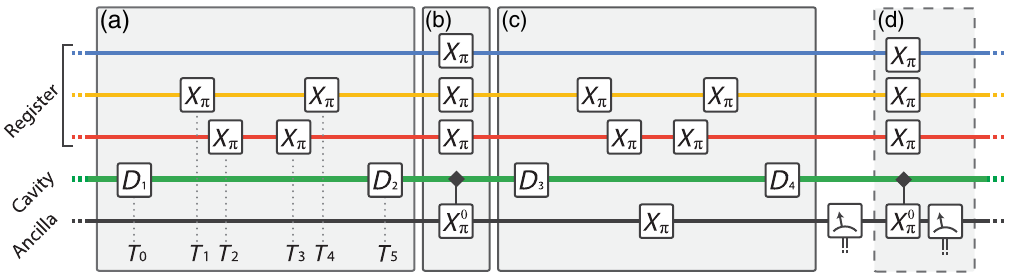
FIG. 2. Circuit diagram for ZIZ measurement. Steps X π refer to one-qubit rotations around the X axis by π radians. Steps X 0 π indicate that the pulses are spectrally narrow and are roughly selective on having zero photons in the cavity. Steps D represent unconditional i displacements of the cavity. The meters are measurements of the ancilla via the readout resonator, which is not itself depicted. The ancilla has the largest dispersive shift and the register qubits are then numerically ordered (from top to bottom) such that χ 1 < χ 2 < χ 3 . Prior to this procedure a series of measurements is applied to postselectively prepare the ground state; see the Supplemental Material for details [32]. (a) The algorithm begins with a displacement D 1 to create a coherent state of ¯ n ¼ 5 photons into the cavity, which acquires a phase shift θ in a time T ¼ T 5 − T 0 ≈ θ = ð 2 πχ 1 Þ conditionally on the state of qubit 1 (blue line). For measurements of one- and two-qubit properties, θ ¼ 2 π = 5 . In this example, we perform a full echo on the second qubit (yellow line) by performing two unconditional X gates separated in time by T 4 − T 1 ≈ T= 2 . The third qubit (red line) would contribute a conditional phase shift of 2 πχ 3 T > θ . We reduce this to θ by performing two X π gates separated by T 3 − T 2 ≈ θ ð χ − 1 1 − χ − 1 3 Þ = 2 . At T 5 , we perform D 2 to shift the odd two-parity coherent-state pointer to the zero-photon state. Note that the overlaps between the even two-parity pointer states and the zero-photon state are exponentially suppressed. (b) We map this photon number information onto the ancilla qubit with a X 0 π gate, taking advantage of the well-known number-splitting phenomenon [35]. As the cavity states are separated by ≈ 6 . 5 photons, we employ a faster, approximately selective gate, 300 ns in duration. X π gates on the register are centered on this pulse in time to echo away the cavity evolution during this step. (c) To disentangle the cavity pointer states, we essentially invert the pulse sequence of (a), returning the cavity to the vacuum state. We must also echo the ancilla, as it may now be excited. This results in a total gate length of 970 ns. Subsequently, we measure the ancilla qubit. (d) This optional step determines if there are residual photons in the cavity. Since many types of errors result in residual photons, a subsequent photon-number-selective rotation and measurement of the ancilla heralds these errors. When measuring